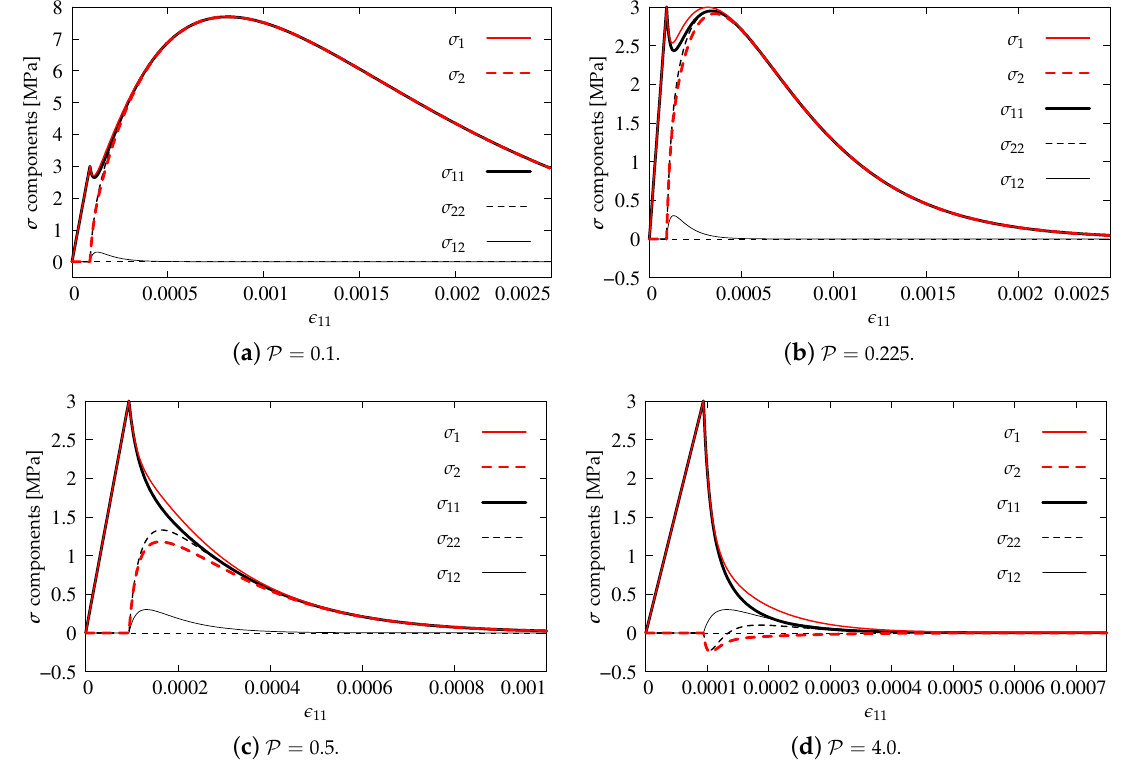
Figure 14. Comparison of stress components for the IDA